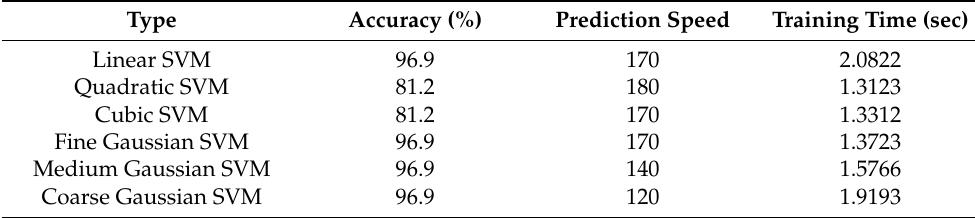
Table 5. SVM 2 DGA classification outcomes.